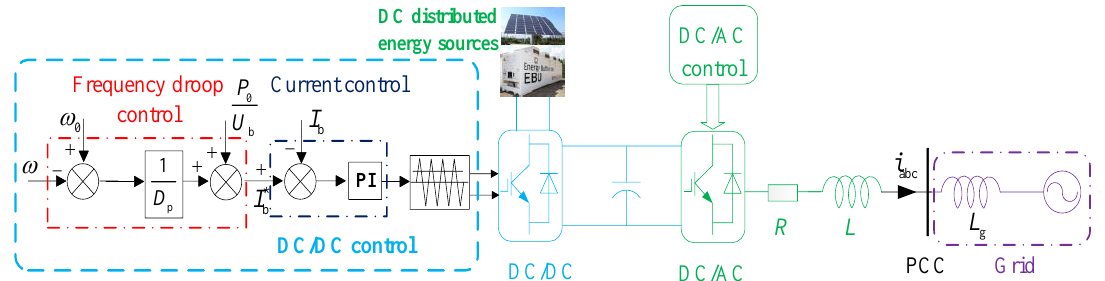
Figure 5. Control block diagram of the DC/DC converter.